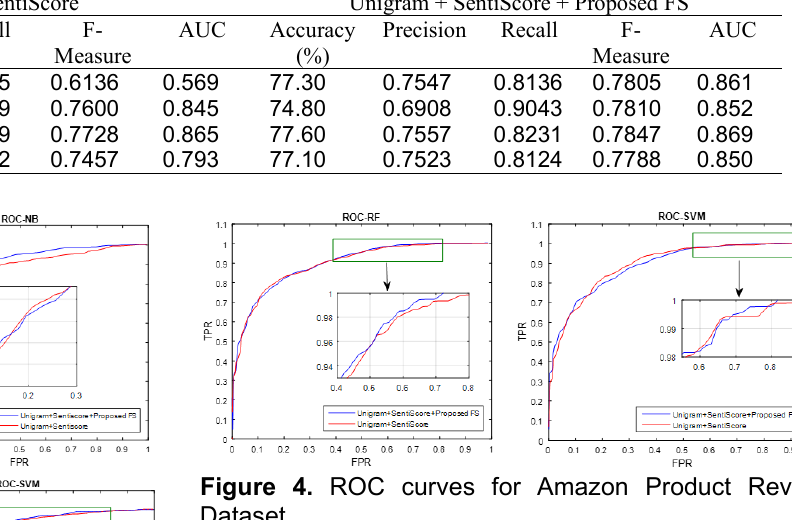
Figure 4. ROC curves for Amazon Product Review